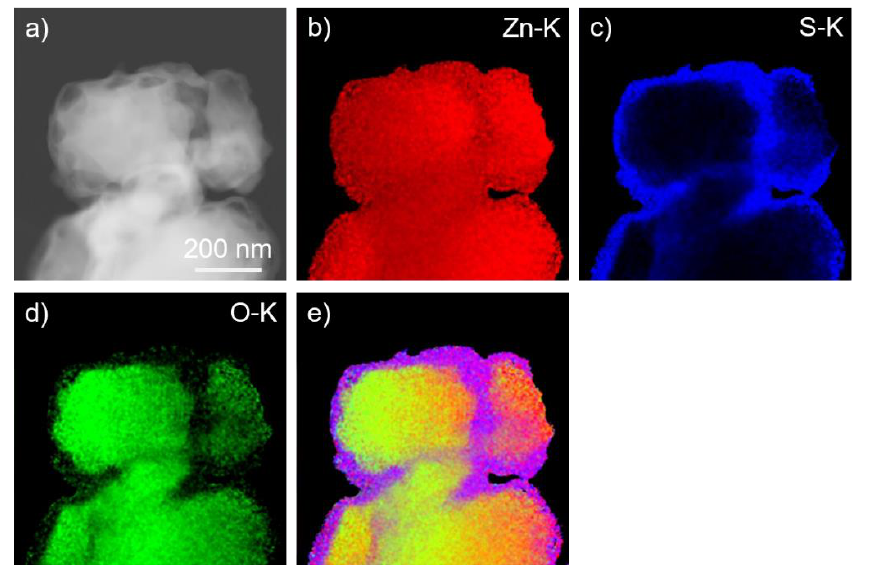
Figure 2. ( a ) HAADF-STEM image of ZnO/ZnS core – shell nanoparticles with corresponding Zn – K, ( b ) S – K, ( c ) O – K, ( d ) EDX elemental maps, and map ( e ) with superimposed ( b – d ) elemental maps.